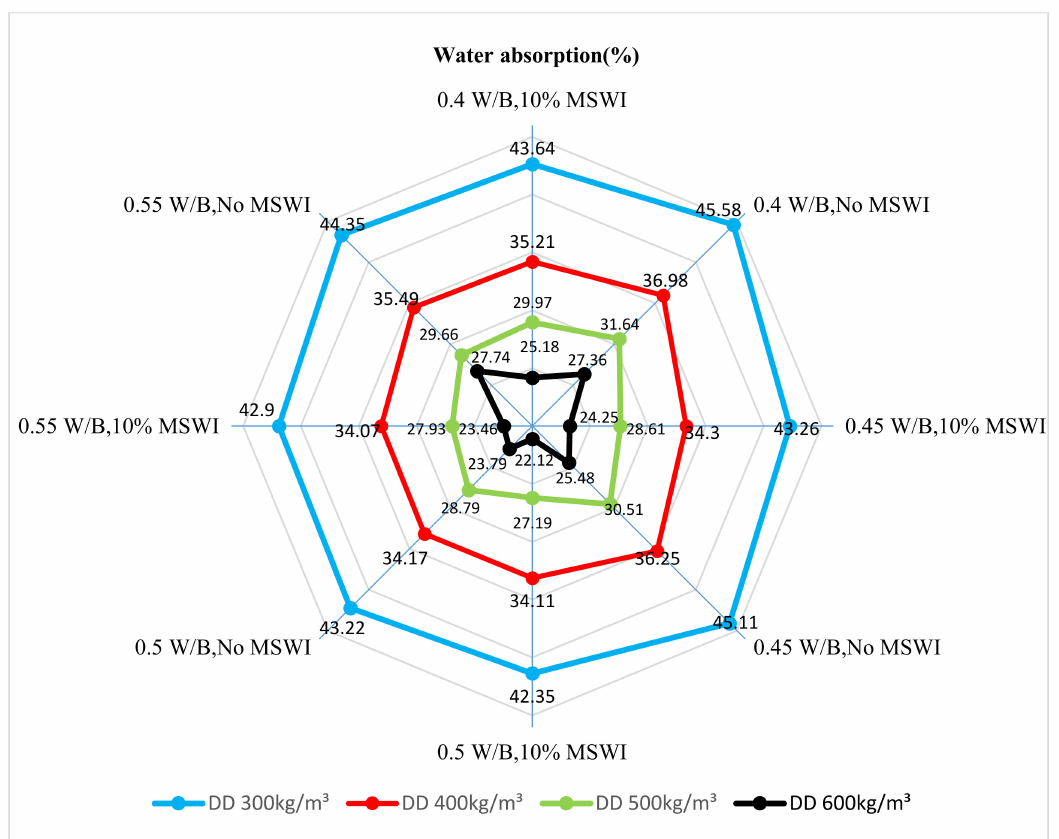
Figure 8. Water absorption of the recycled foamed concrete containing MSWI powder with different w/c